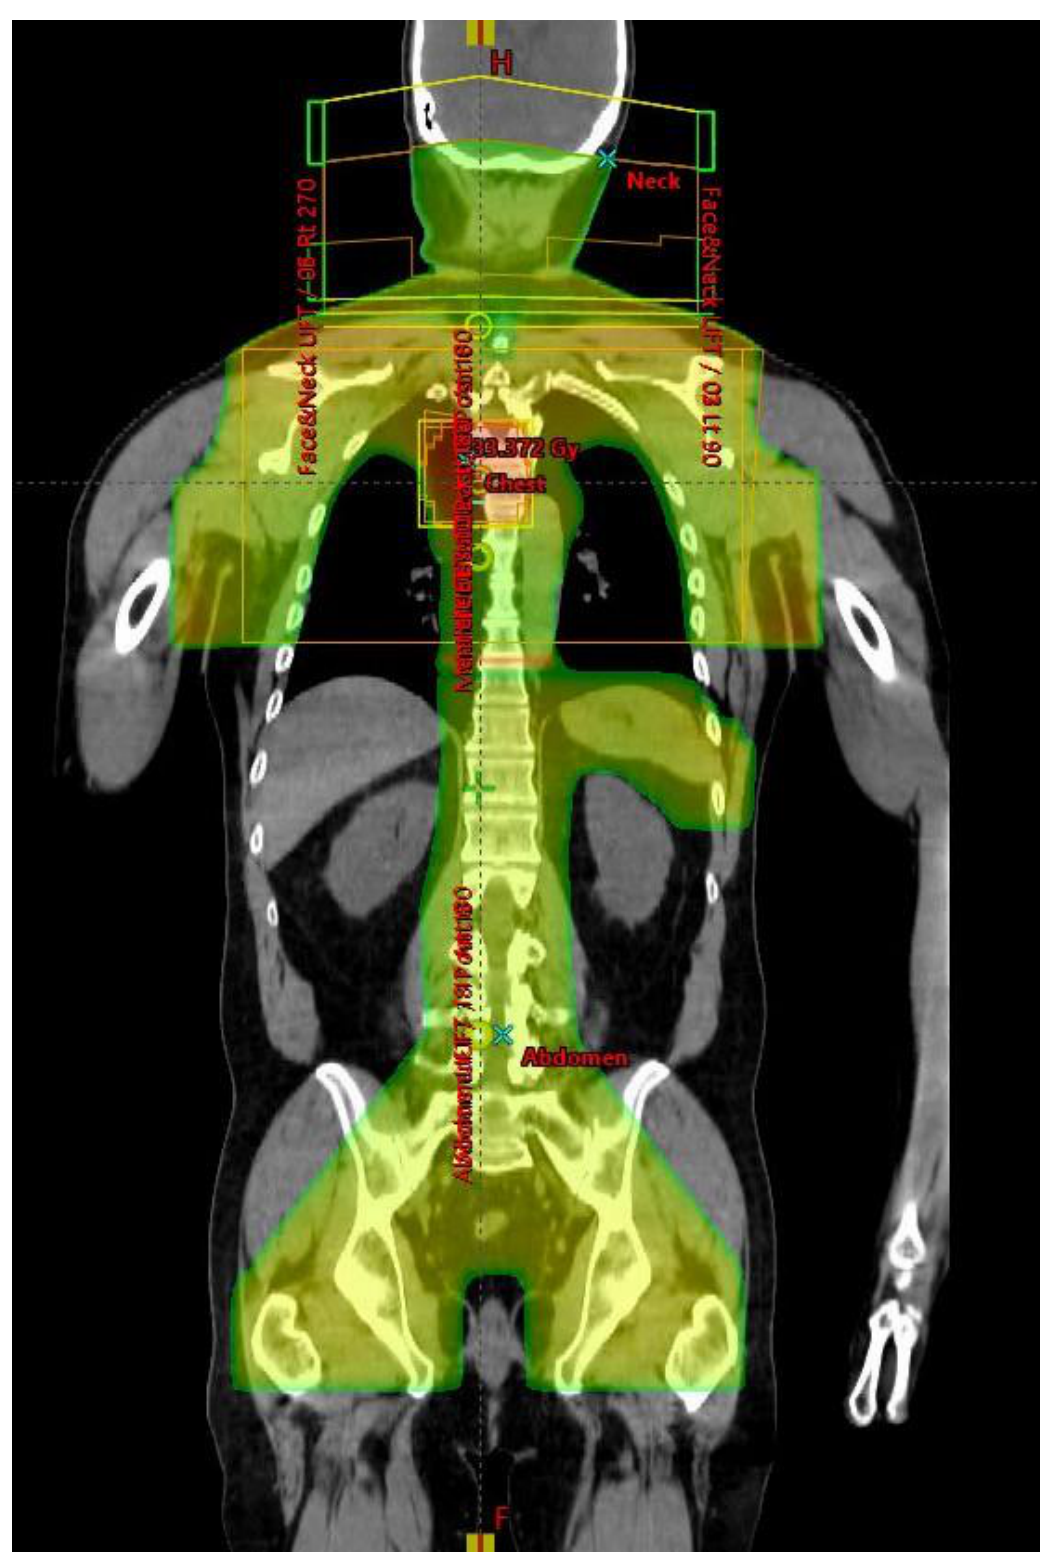
Figure 6. Total Nodal Irradiation dose distribution (coronal view).